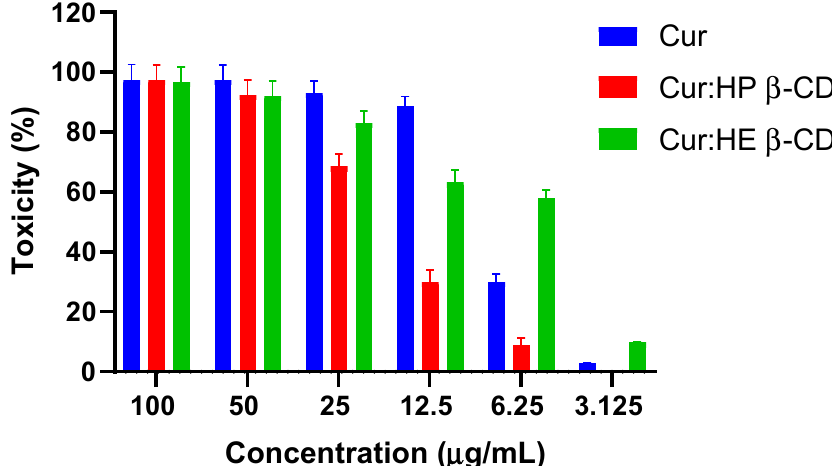
Figure 7. Cytotoxicity (%) estimated for six serially diluted concentrations (3.125 to 100 µg/mL) curcumin, curcumin: HP β -CD Coppt, curcumin:HE β -CD Coppt. Results expressed as mean ± SD, n = 3.